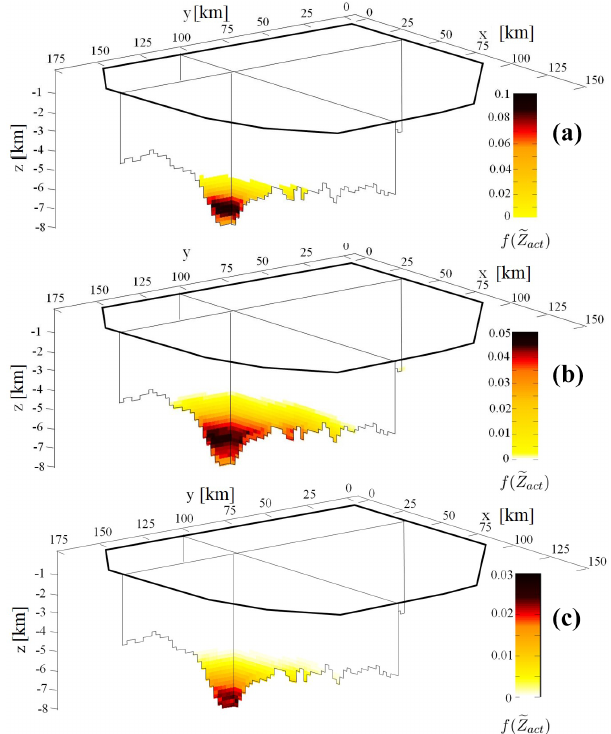
Figure 5. Spatial distribution of f ( (cid:101) Z act ) computed at t = 0Ma along two planar perpendicular sections of the basin case study lo- cated at x = 32km and y = 105km for CCR1 (a) , CCR2 (b) and CCR3 (c)